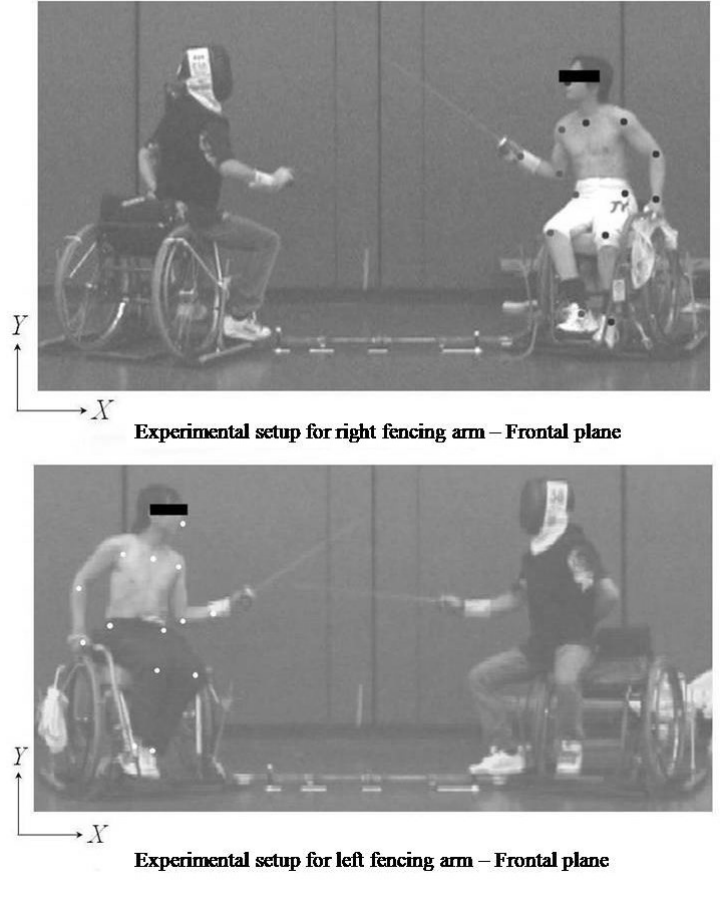
Experimental setup for right and left fencing arm.